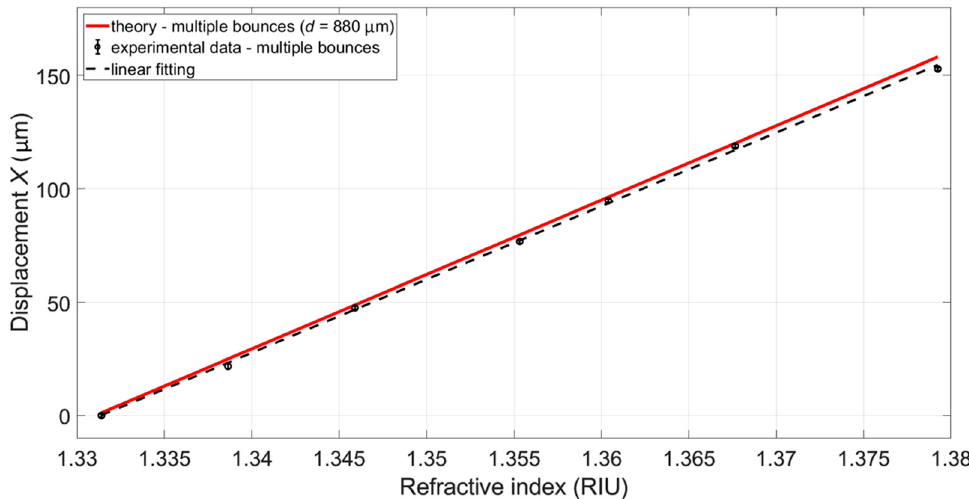
Figure 4. Theoretical and experimental calibration curves obtained by considering water and glucose–water solutions filling the channel.